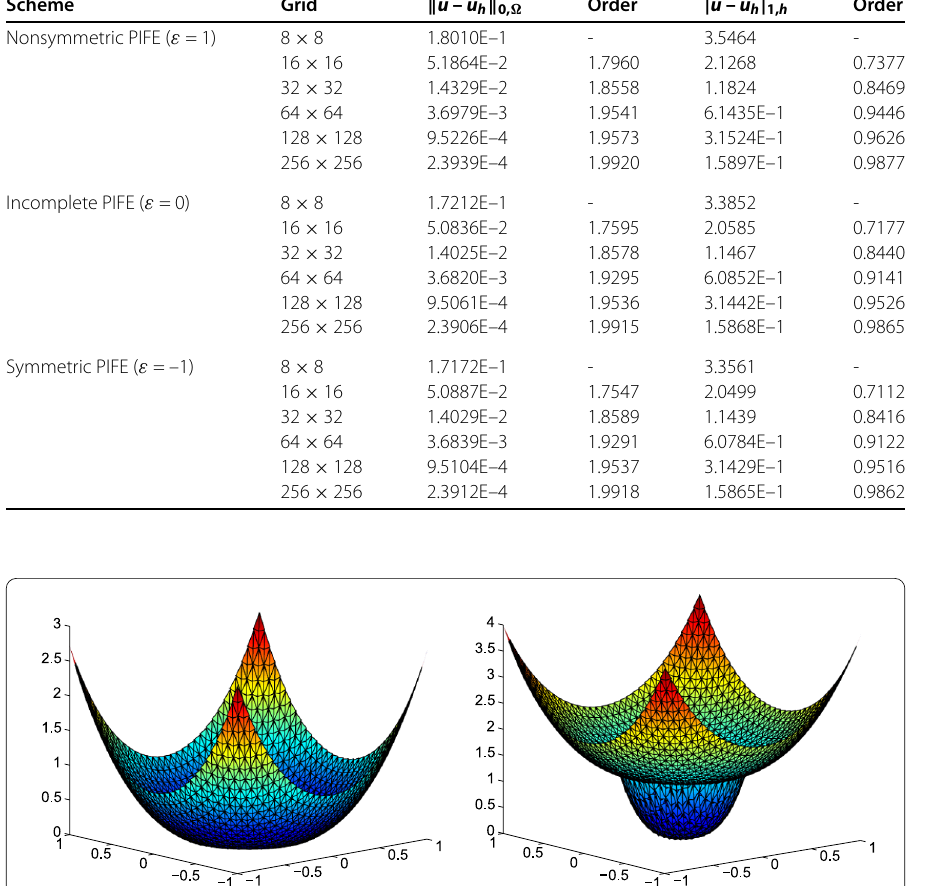
Figure 4 Numerical solutions under the triangular grid with N =